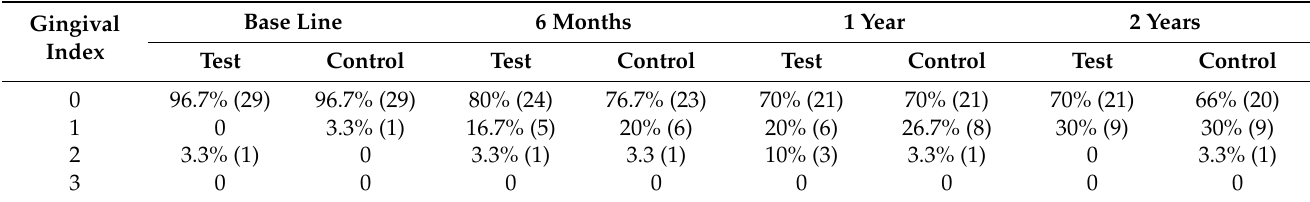
Table 3. Gingival index (GI) (%) scores.